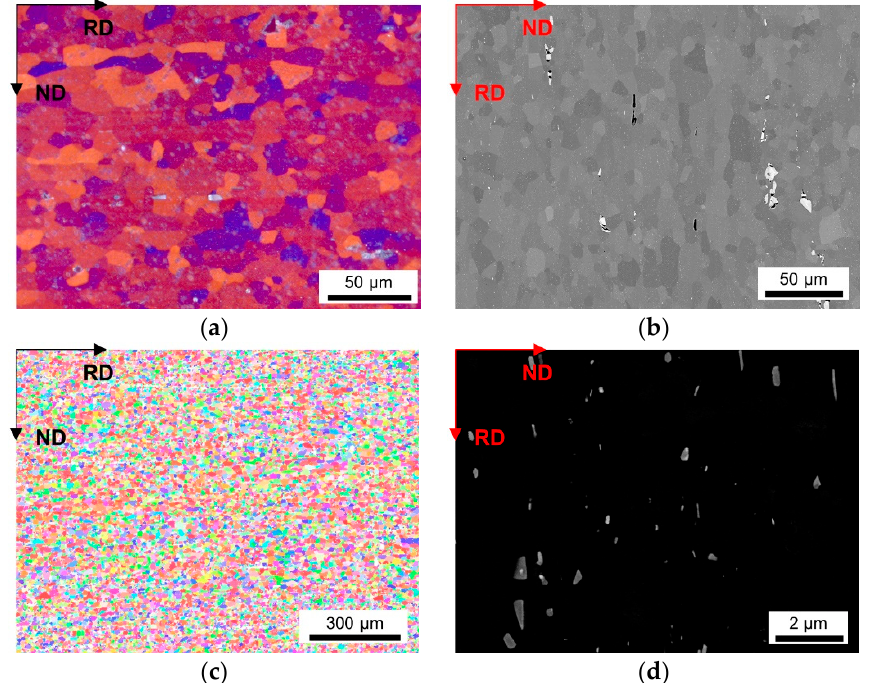
Figure A13. Microstructure of the soft annealed LFe-HMn cast under S-C conditions, homogenized at 550 °C and cold rolled to a CRD of 63%. ( a ) LOM. ( b ) BSE image. ( c ) EBSD IPF map in RD–ND plane. ( d ) BSE micrograph showing dispersoids.